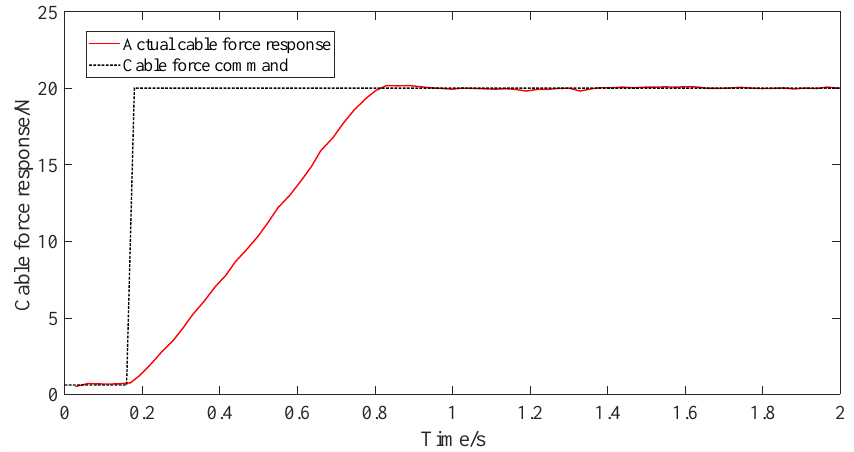
Figure 11. Step force response of cable actuator.